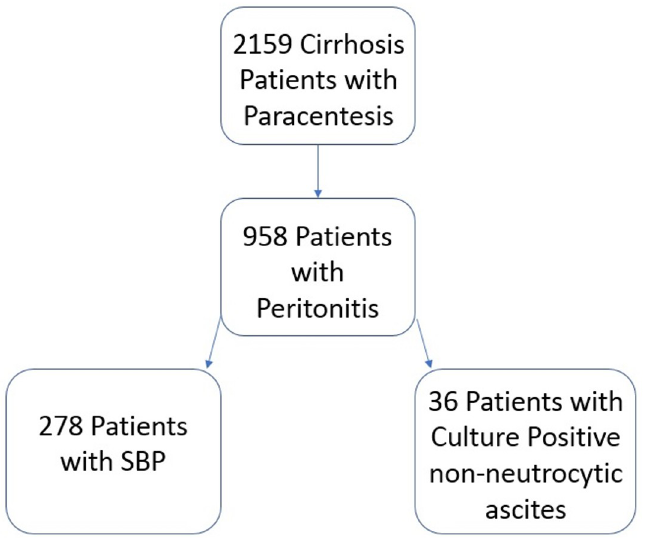
Fig 1. Stepwise process of data mining starting with EDW patient